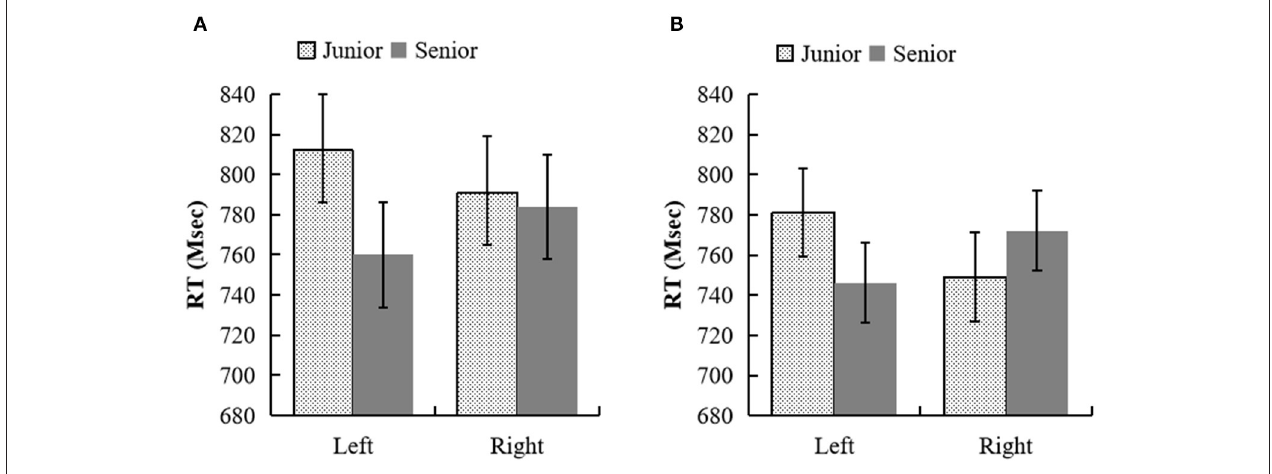
FIGURE 2 | (A) RTs (in proportions) for the semantic judgment task of kin terms in experiment 2a. (B) RTs (in proportions) for the target letter identification task (m–w judgment) in experiment